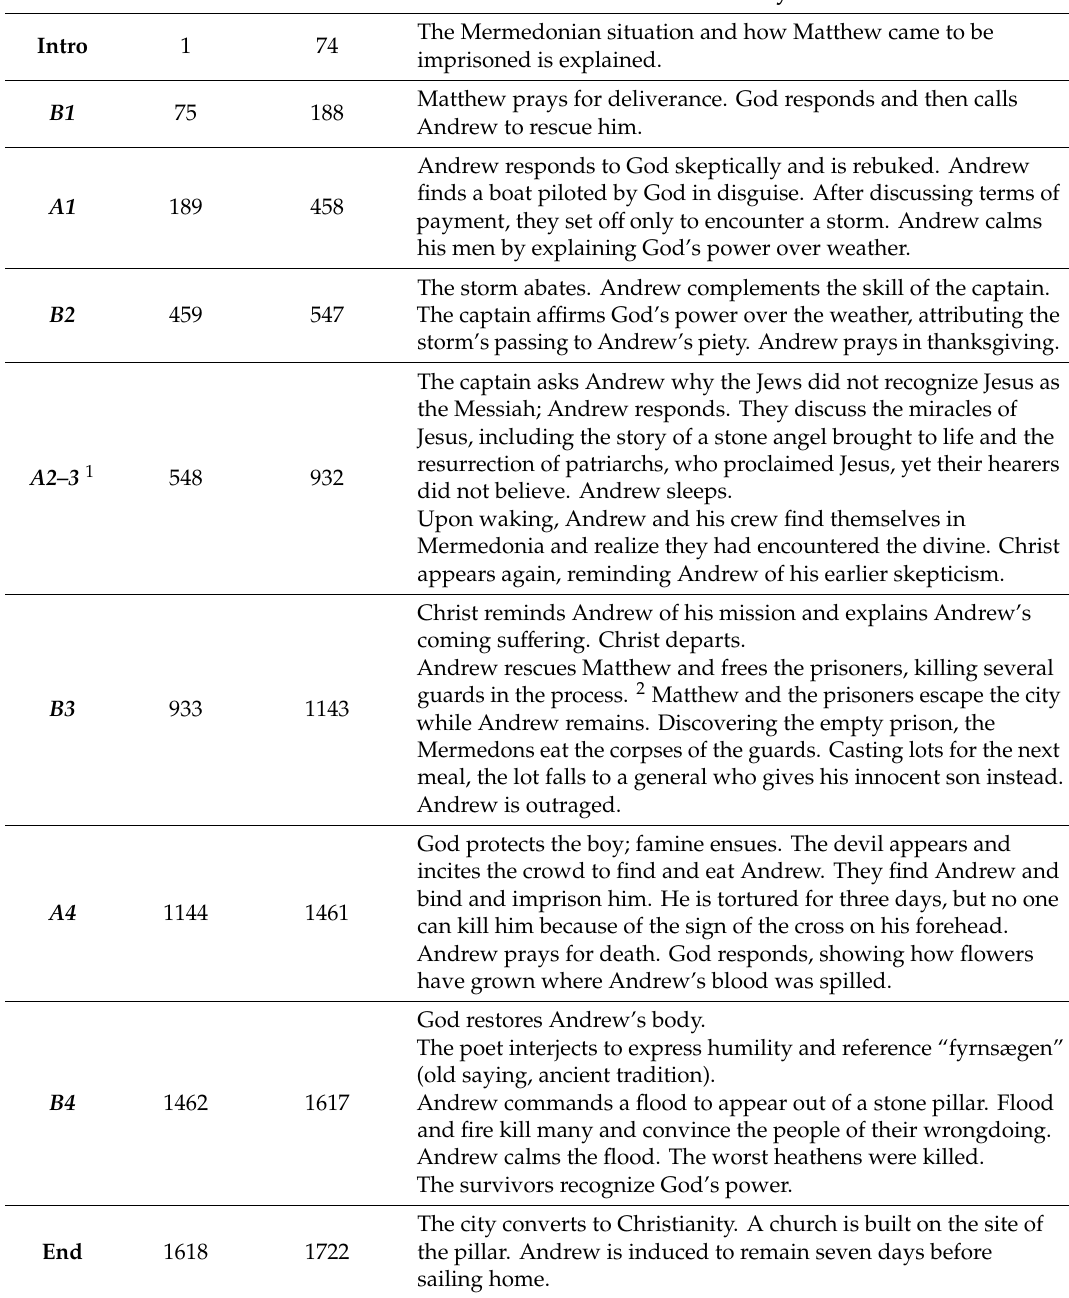
Table 1. The A and B sections in Andreas